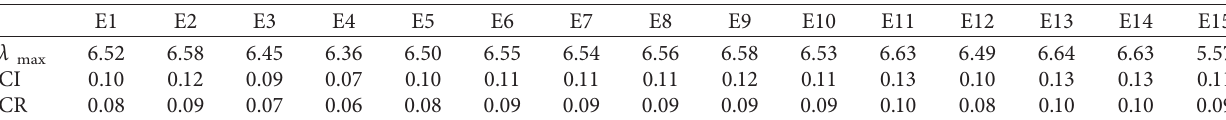
Table 4: Results of consistency ratio ( n � 6, RI �